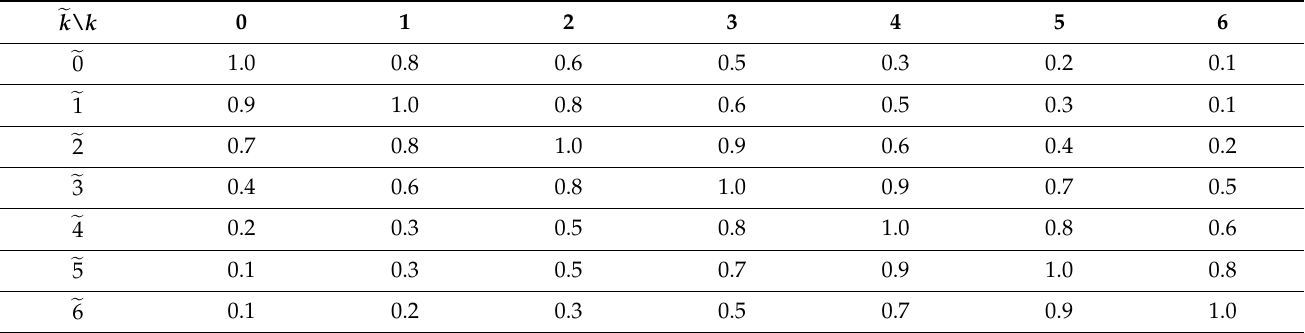
Table 3. Fuzzy subsets “approximately k successes” ( k = 0,1,2,3,4,5,6